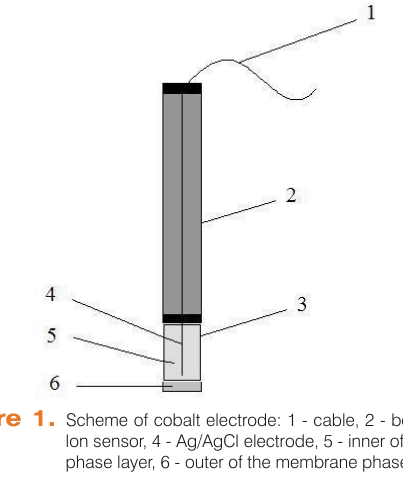
Figure 1. Scheme of cobalt electrode: 1 - cable, 2 - body, 3 - Tef- lon sensor, 4 - Ag/AgCl electrode, 5 - inner of membrane phase layer, 6 - outer of the membrane phase layer.